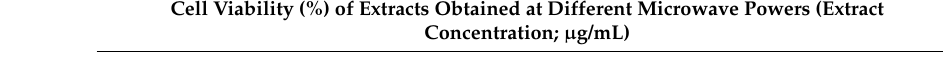
Table 1. Maximum values of cell viability of human tumoral cells contacted with the liquid phases obtained after microwave hydrodiffusion gravity-ultrasound assisted extraction stage, where the powers of microwave were from 100 to 500 W and the ultrasound-assisted extraction was alike for all the residue samples (5 h, 1.5 A, 150 W, and 40 Hz). The TG98 cell line did not shows cell inhibition. Data represent the mean ± SEM ( n = 3).